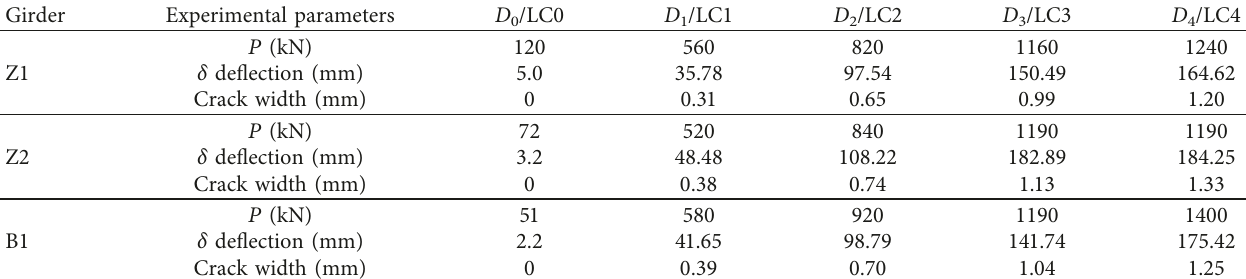
Table 4: Experimental data for girders subjected to cycles of static